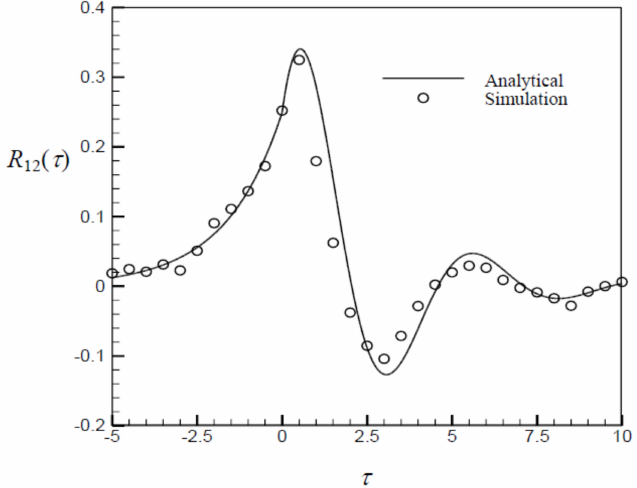
Figure 5. Cross − correlation function R 12 ( τ ) of X 1 ( t ) and X 2 ( t ) for Equation (9) using the method of series expansion with random phases.